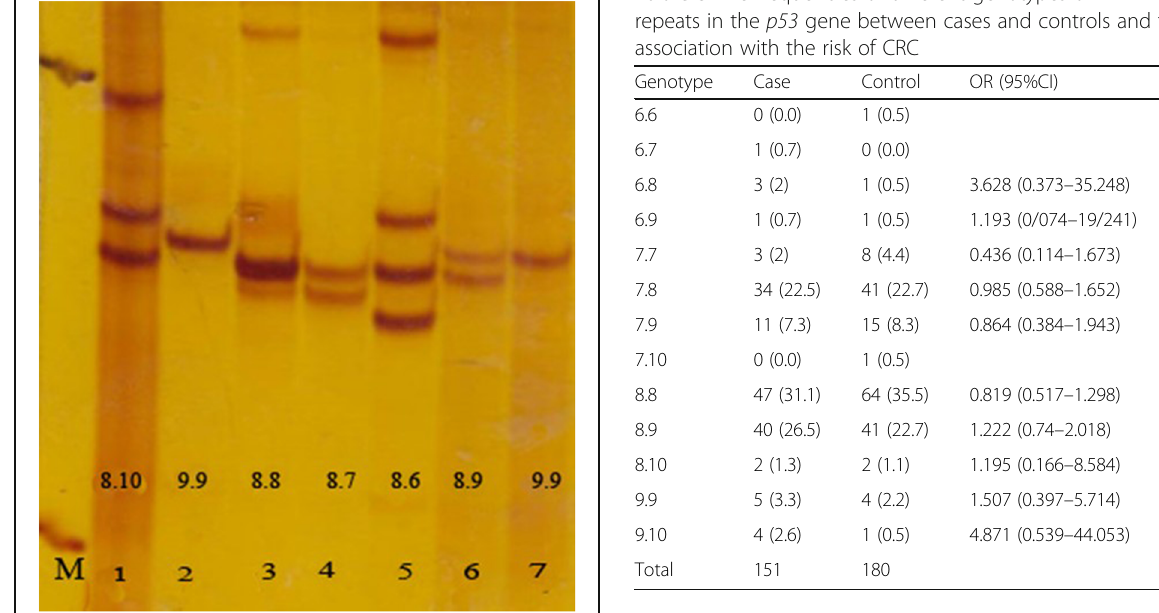
Table 3 The frequencies of different genotypes of